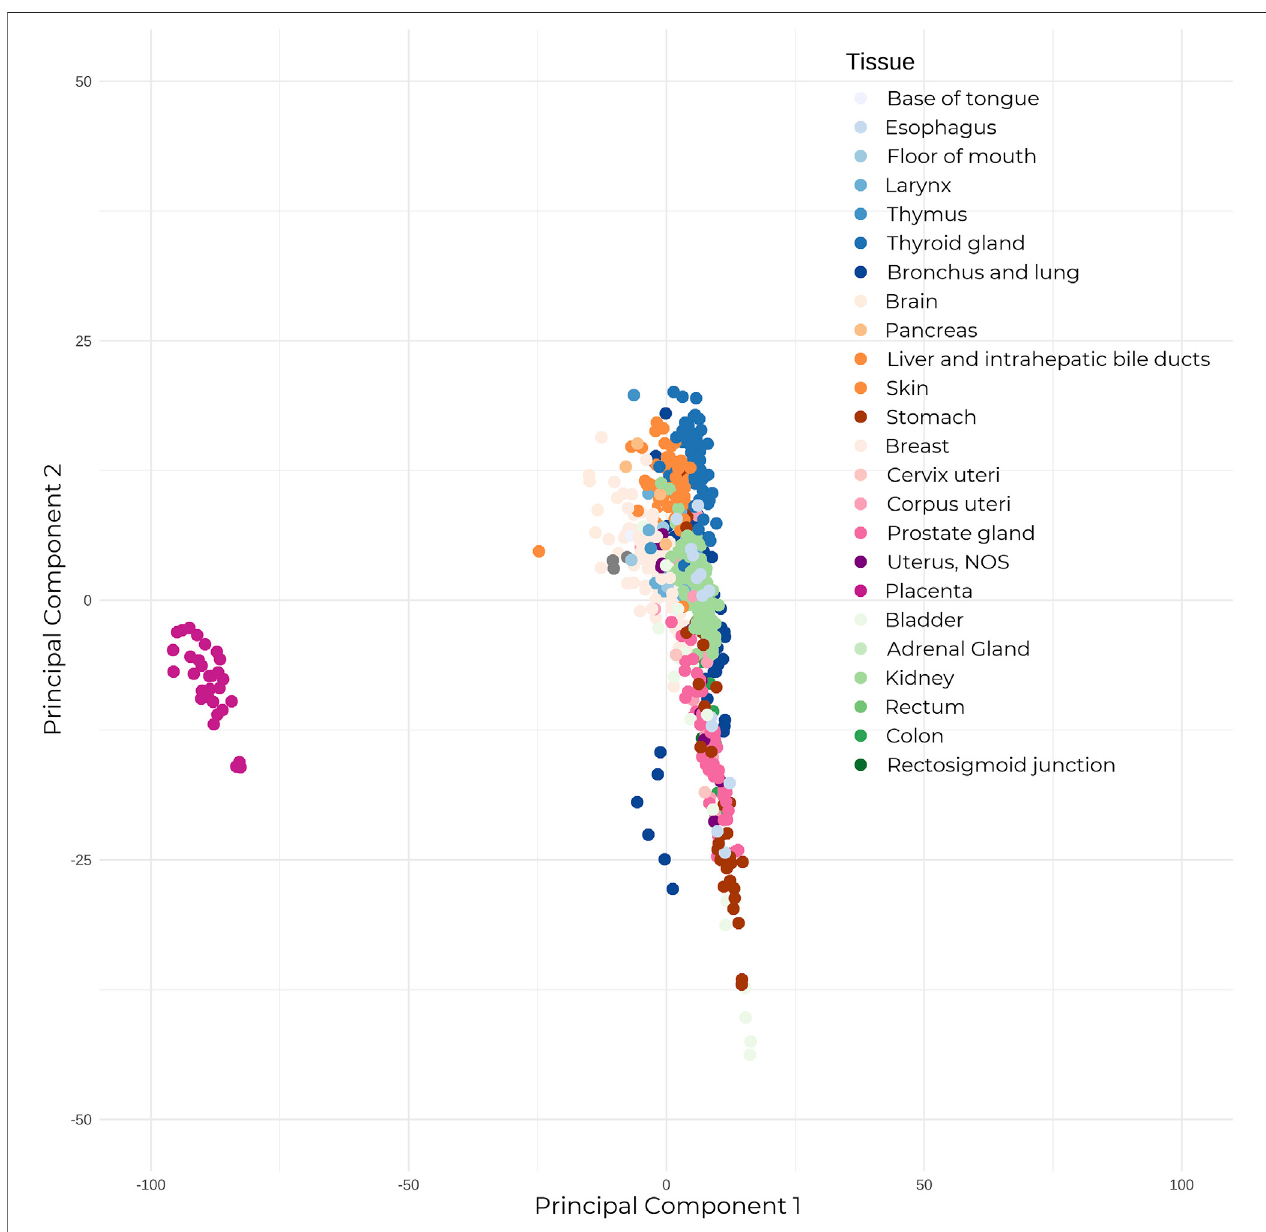
FIGURE 1 | The placenta shows signi fi cantly different expression to adult healthy tissue. Mature microRNA expression between 30 placental tissue samples, and 23 healthy adult human tissue (679 total samples). Expression counts were TPM-normalized, and samples were subjected to Principal Component Analysis. Placental samples annotated in dark pink on the left show clear segregation from the adult tissue